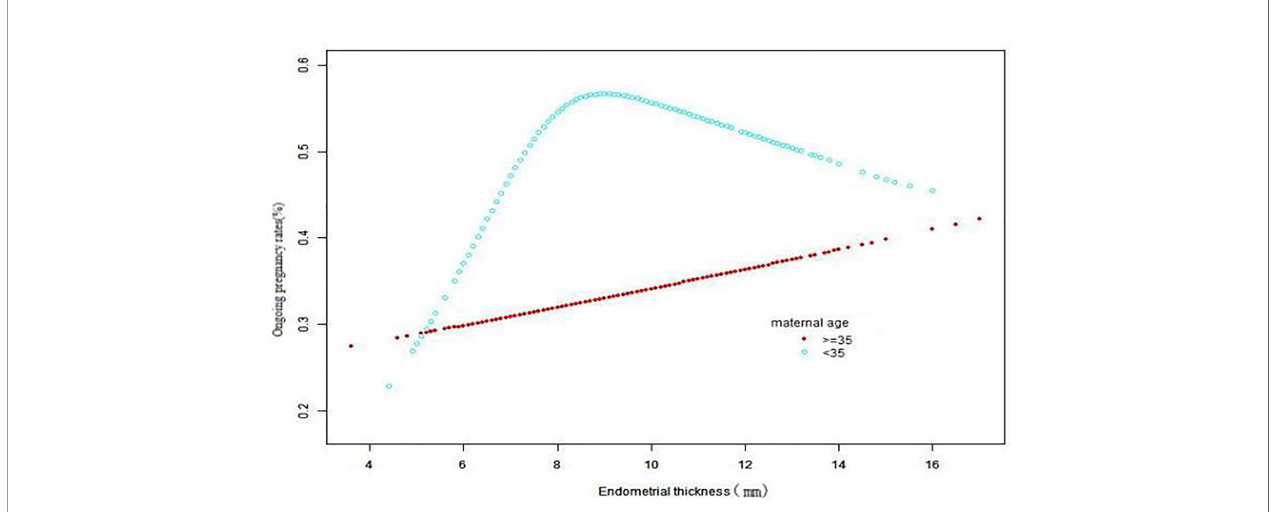
FIGURE 2 | The association between EMT and OPR in two groups of women. A nonlinear relationship for women < 35 years and a linear relationship for women ≥ 35 years were detected after adjusting for endometrial preparation protocol, duration of infertility, maternal height, number of good-quality embryos transferred, number of transferred cycles, and stage of embryo